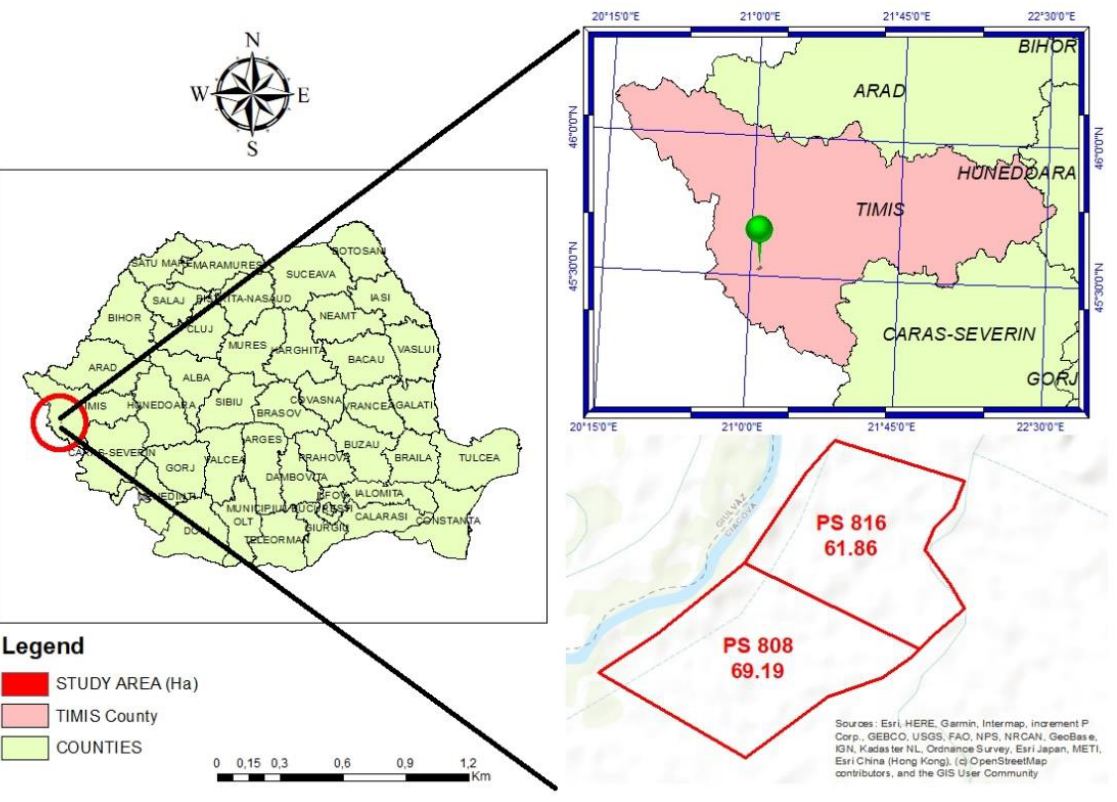
Figure 1. Location of the studied agricultural land of the pasture category, Ciacova locality, Timiș County, Romania.